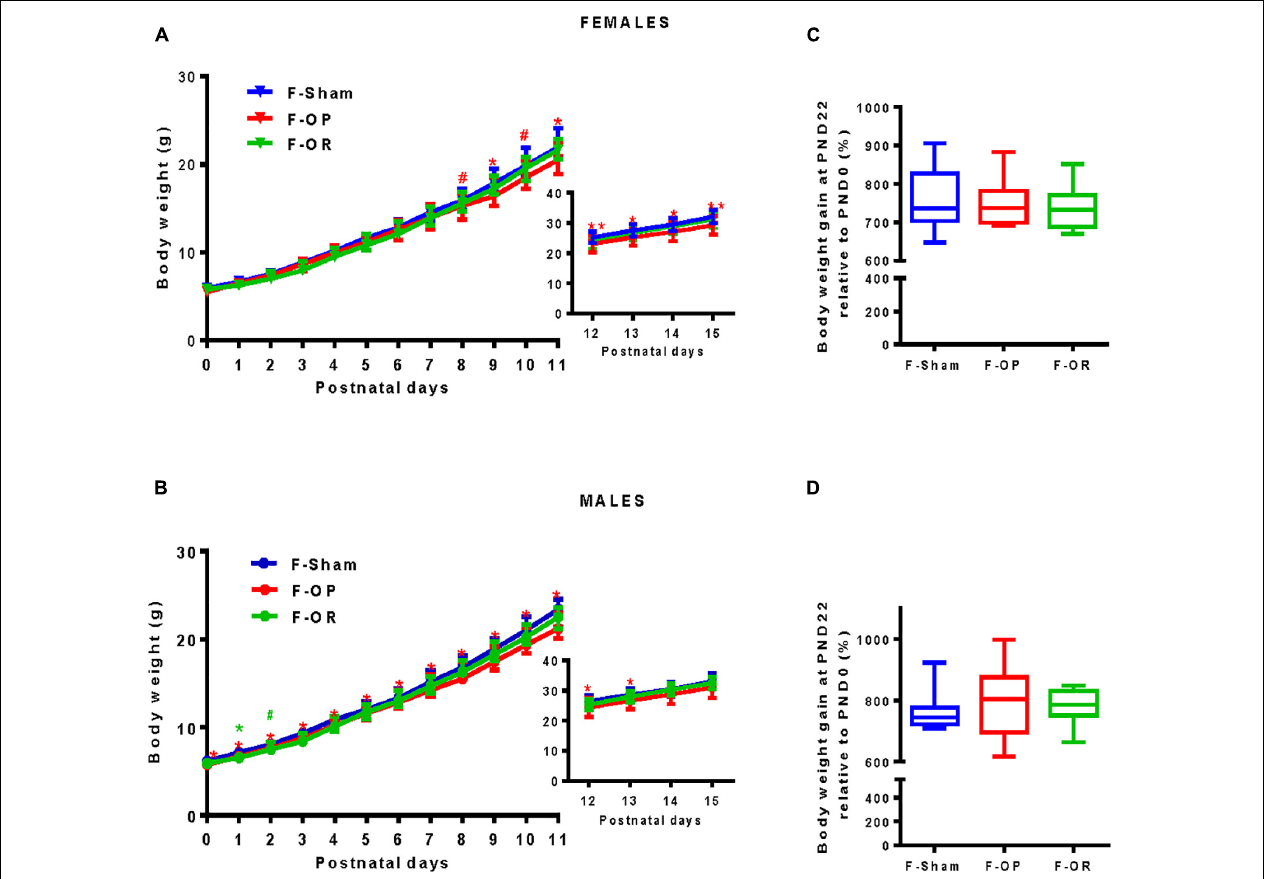
FIGURE 5 | Pups’ growth during the lactation period. Bodyweight of female (A) and male (B) , from birth to PND11 (females n = 22–25, males n = 23–26) and in inserts from PND12 to PND15 (females n = 16–19, males n = 17–20), data are medians and interquartile range, * p < 0.05, ** p < 0.01, # p < 0.1, Kruskal–Wallis and post hoc Dunn’s test at each PND. “*” and “**” indicate differences (“ # ” tendency) between F-OP and F-Sham; “*” indicates differences (“ # ” tendency) between F-OR and F-Sham. (C,D) Relative bodyweight (%) obtained by dividing body weight gain at PND22 by body weight at birth of females ( C , n = 7–9) and males ( D , n =